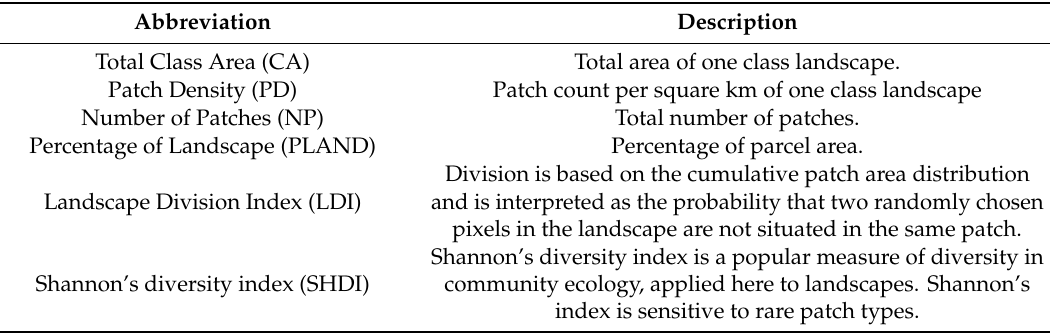
Table 1. Landscape metrics selected in this study.